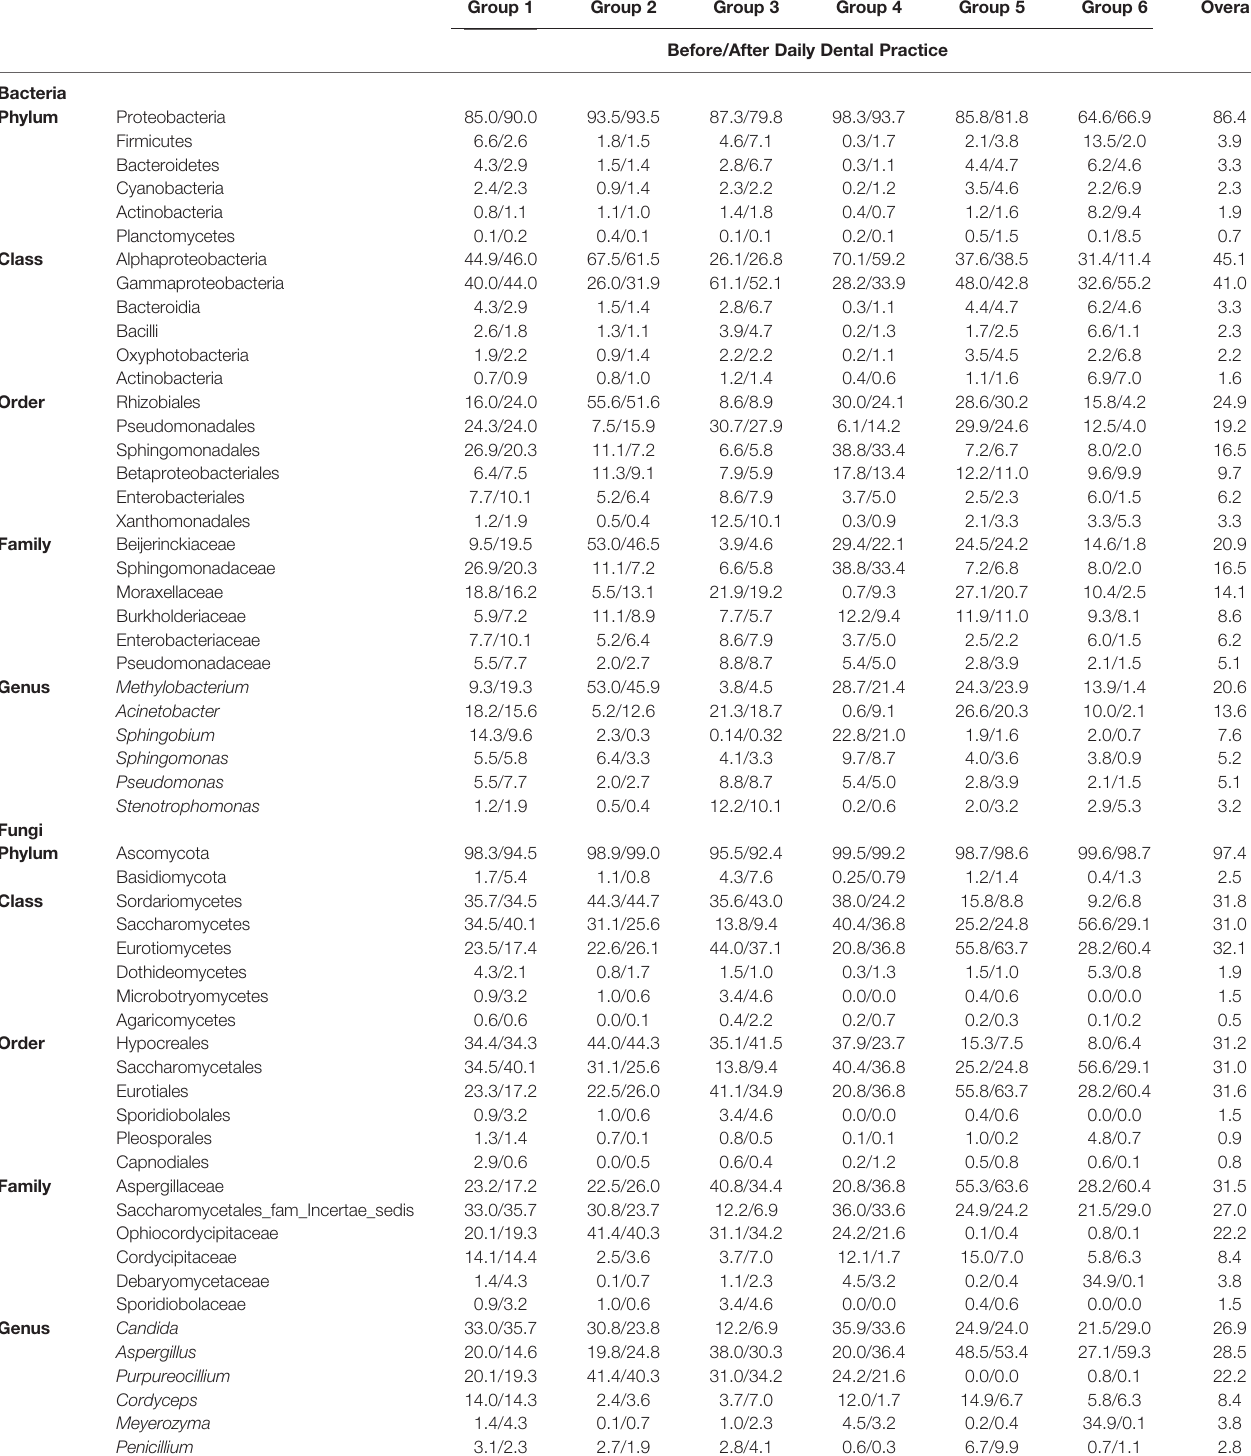
TABLE 2 | The overall relative abundance (%) of top six bacteria and fungi at phylum, class, order, family and genus levels and that among six groups of DUWL bio fi lm samples at two time points (before/after daily dental practice) (relative abundance